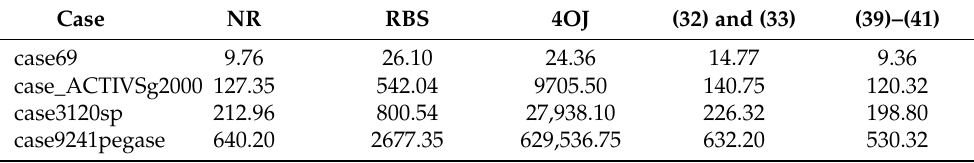
Table 9. Solution times (ms) for well-conditioned cases with limit load